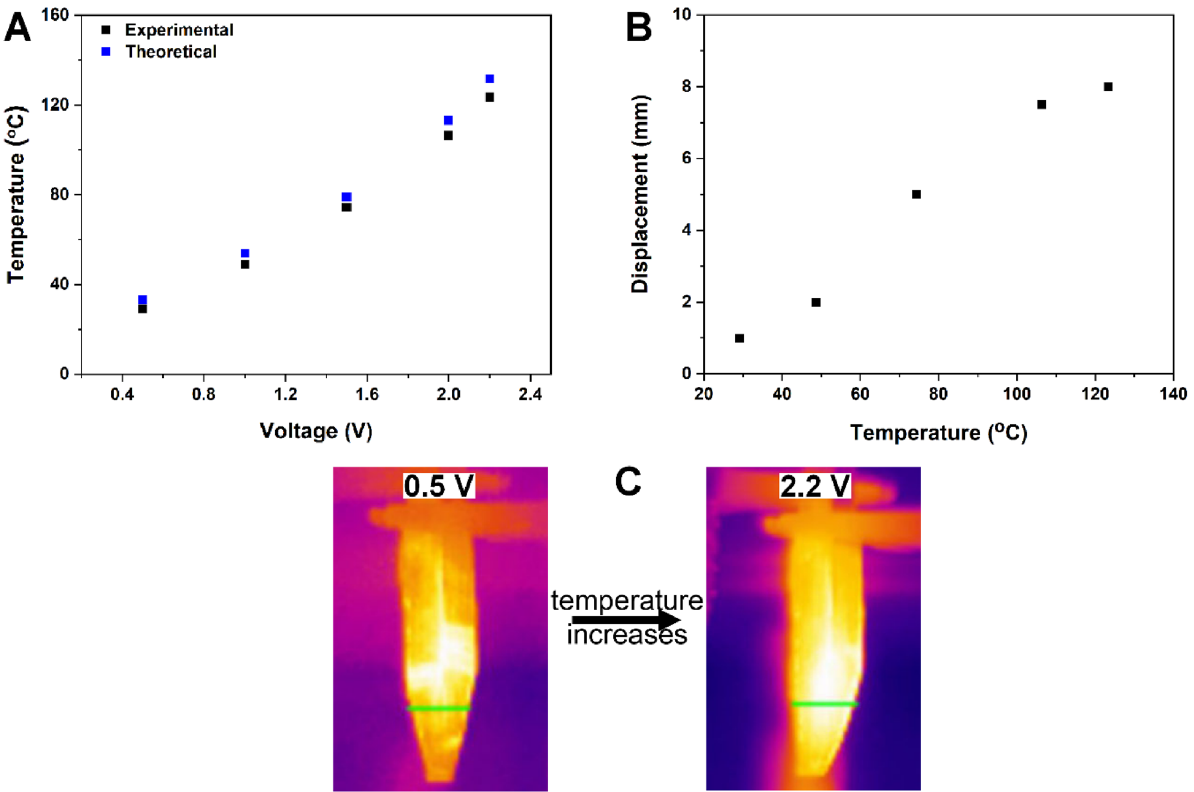
Figure 2. The heating process: ( A ) direct and indirect estimated temperature as a function of the applied voltage and ( B ) tip displacement as a function of local temperature; ( C ) snapshots taken with the IR camera during the artificial muscle